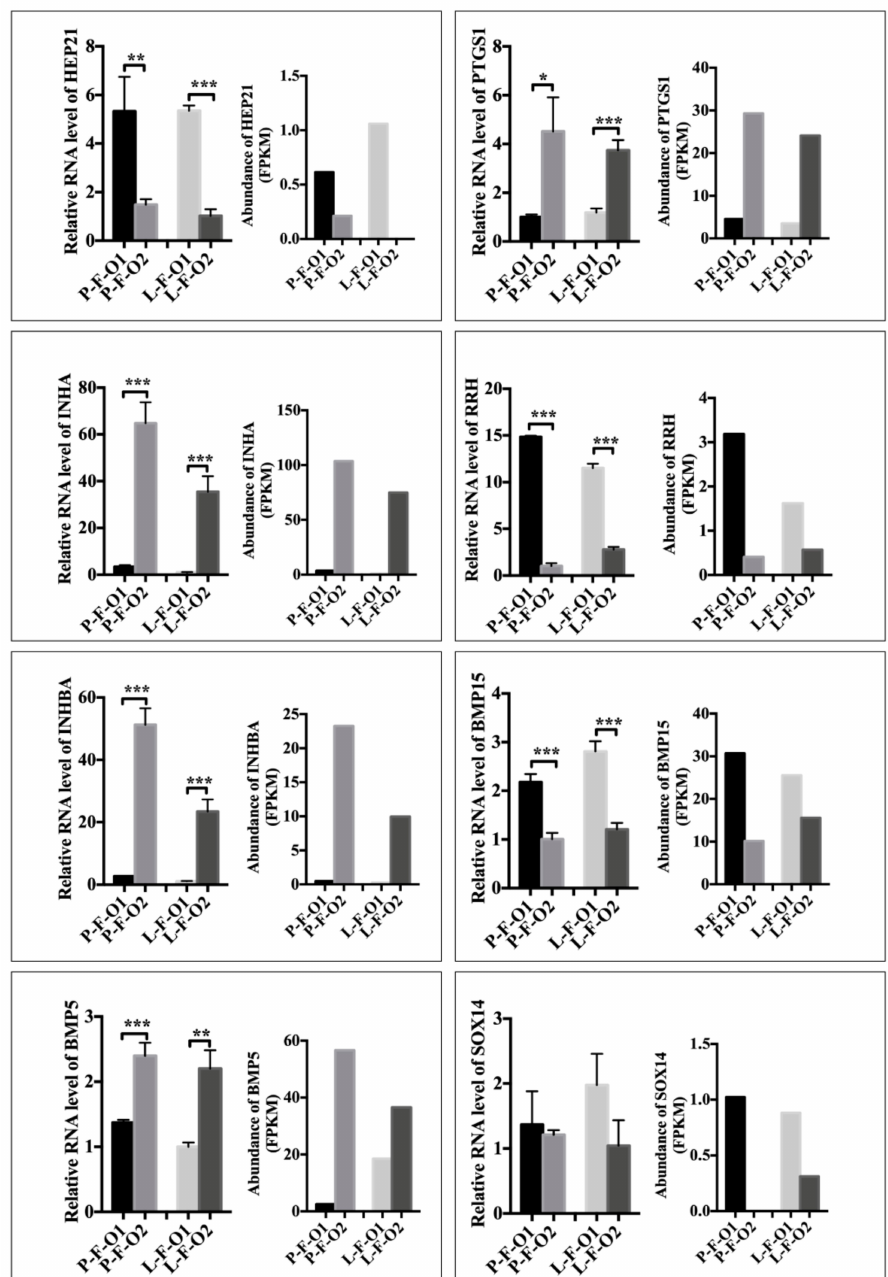
Figure 3. qRT-PCR validation of di ff erentially expressed genes in RNA-seq. Each sample was examined in triplicate in qRT-PCR. Values represent means ± SEM based on qRT-PCR data. * p < 0.05; ** p < 0.01; *** p < 0.001. In RNA-seq data panels, values denote fragments per kilobase of transcript per million mapped reads of each